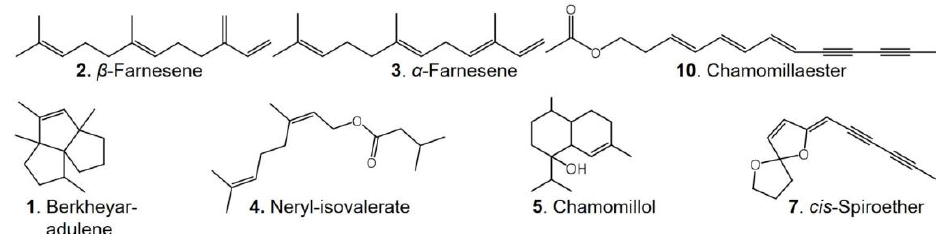
Figure 2. Structures of selected representatives characterized in M. recutita root dichloromethane extracts.